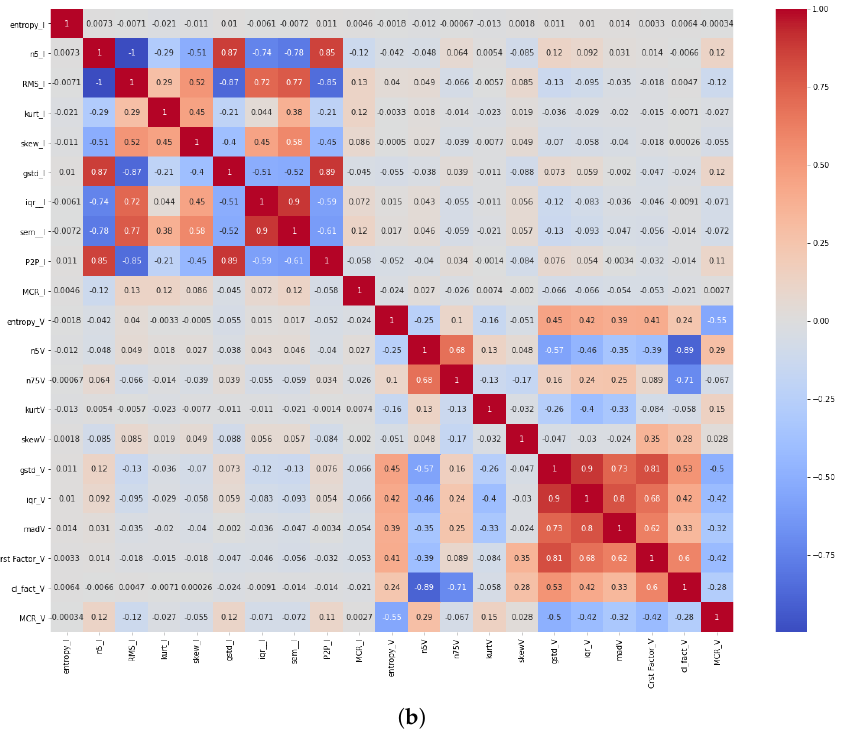
Figure 6. Correlation matrix of extracted features ( a ) All the features ( b ) 21 salient features.